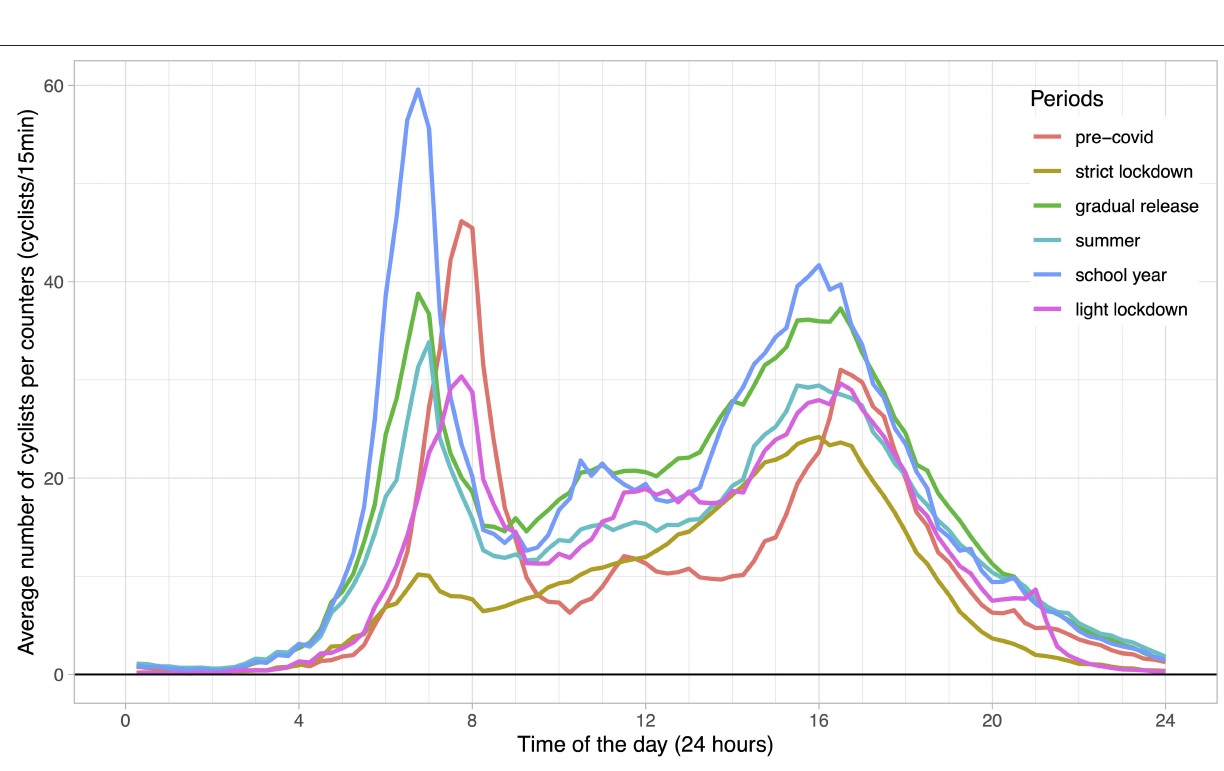
Frontiers in Sustainability |